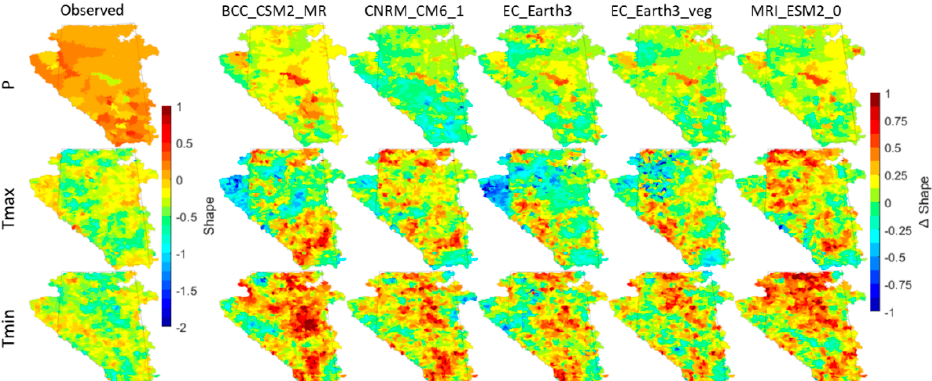
Figure 7. Spatial distribution of the tail index (shape parameter) of P, Tmax, and Tmin extremes for the 1983–2014 period for 2255 sub-basins. The first column in the left represents the magnitude of tail index based on observed data and the rest four columns indicate the difference (delta change) between GCM simulations and observation. A positive shape indicates an overestimation by GCMs.